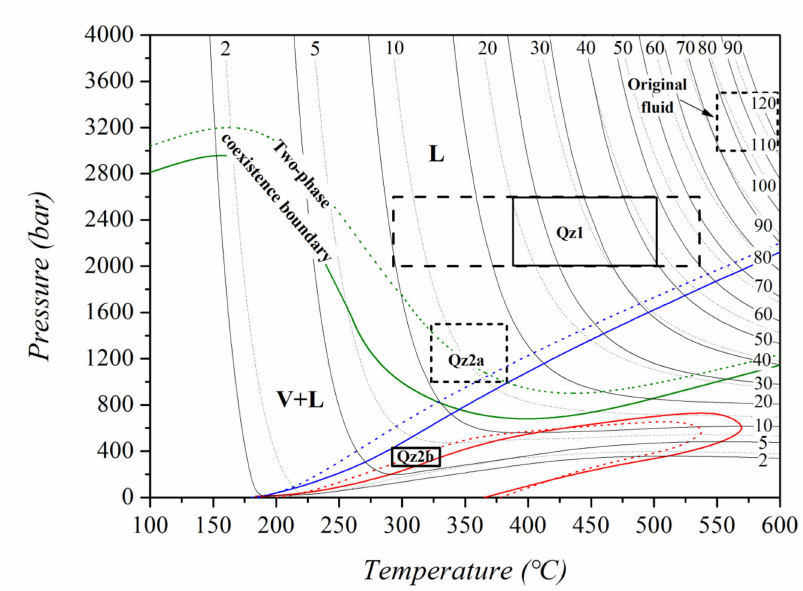
Figure 13. Formation of di ff erent veins in Linglong gold deposit. Notes: The black solid curves and dash curves represent quartz solubility isopleths in liquid and vapor + liquid hydrothermal fluids, containing 10 mol% CO 2 and 5 wt% NaCl and 15 mol% CO 2 and 5 wt% NaCl solute, respectively. The green solid curves and dash curves, the blue solid curves and dash curves, and the red solid curves and dash curves are the boundaries of liquid phase and the vapor + liquid phase, of the TsPi and the PsTi, and of the PsTi and ReSo in di ff erent hydrothermal fluids, containing 10 mol% CO 2 and 5 wt% NaCl and 15 mol% CO 2 and 5 wt% NaCl, respectively. Solid squares show the calculated conditions of Qz1 and Qz2b, while dashed squares show the assumed conditions of original fluids, Qz1 and